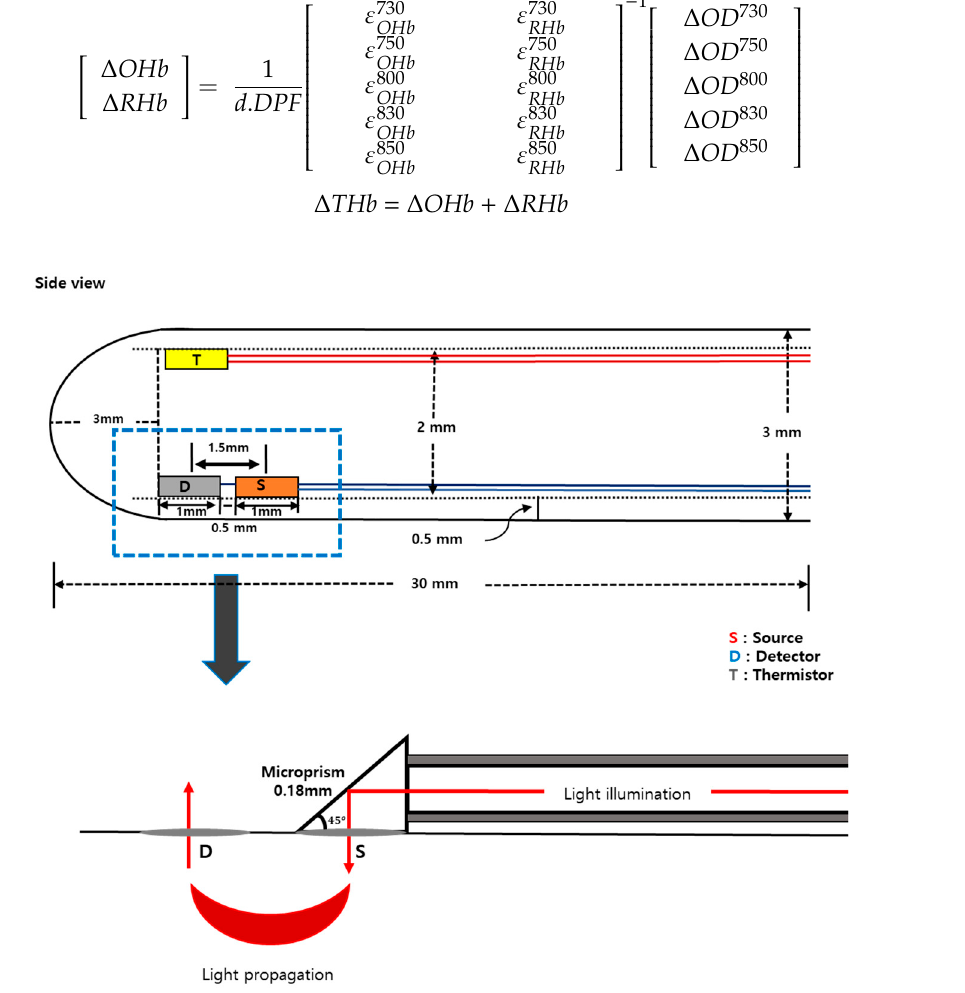
Figure 1. A schematic diagram of the probe’s design.